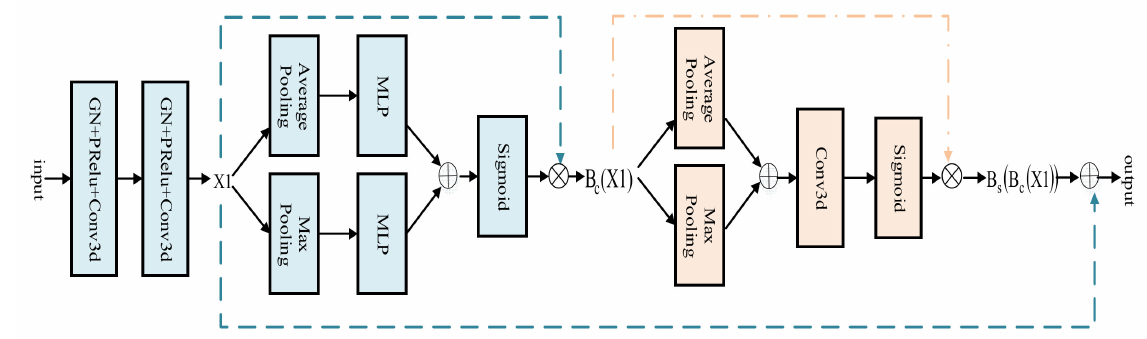
Figure 3. 3D BCS Hybrid Domain Attention Mechanism